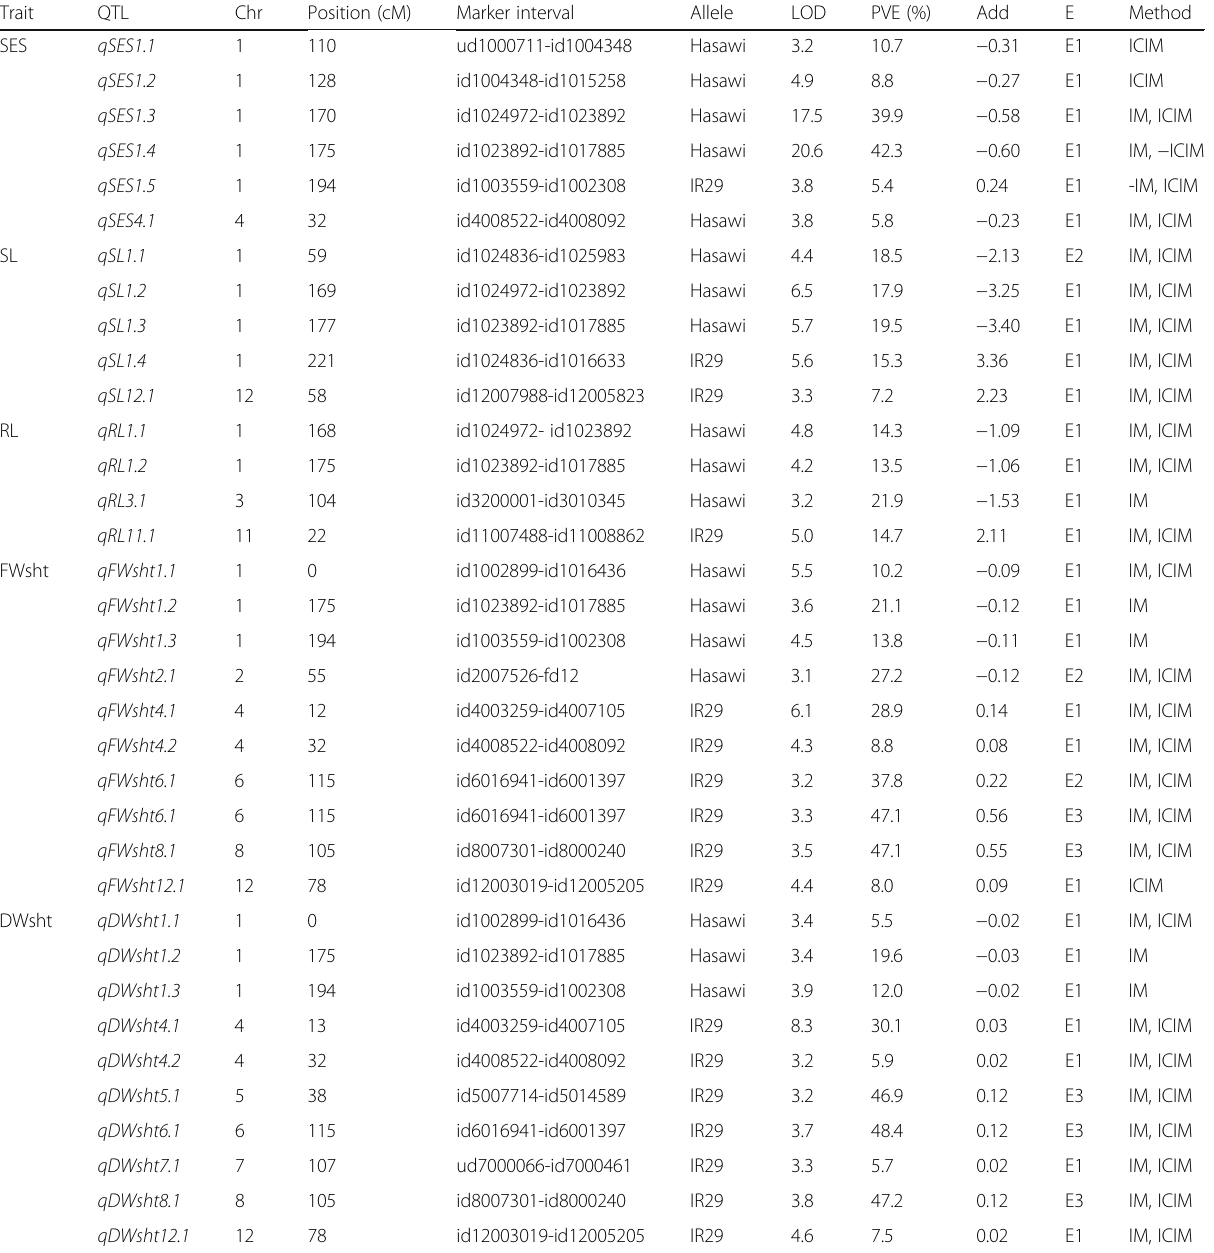
Table 2 QTLs for traits related to salt tolerance during seedling stage in an IR29/Hasawi RIL population in three environments Trait QTL Chr Marker